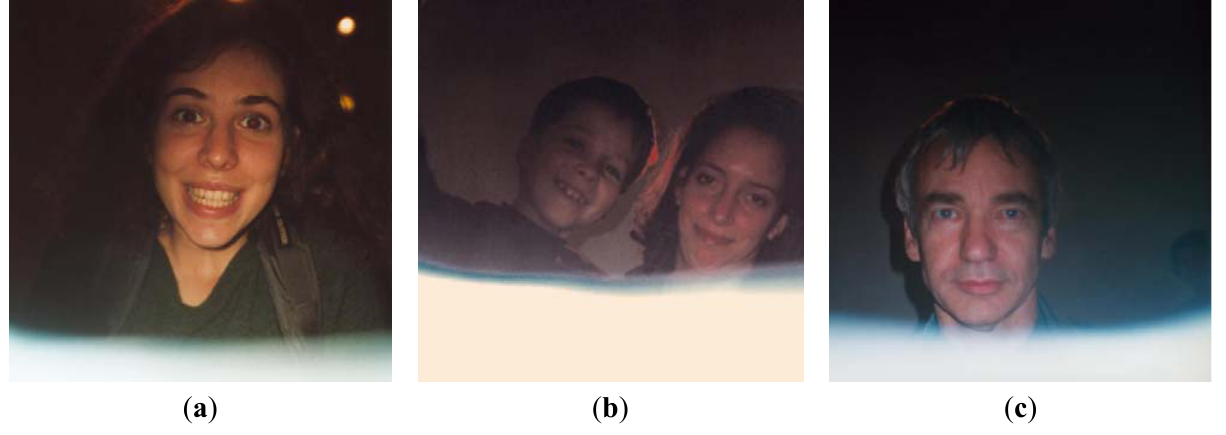
Figure 6. ( a ) Audience Member. Source: the artist and Matt’s Gallery, London. ( b ) Audience Members. Source: the artist and Matt’s Gallery, London. ( c ) Audience Member. Source: the artist and Matt’s Gallery, London,